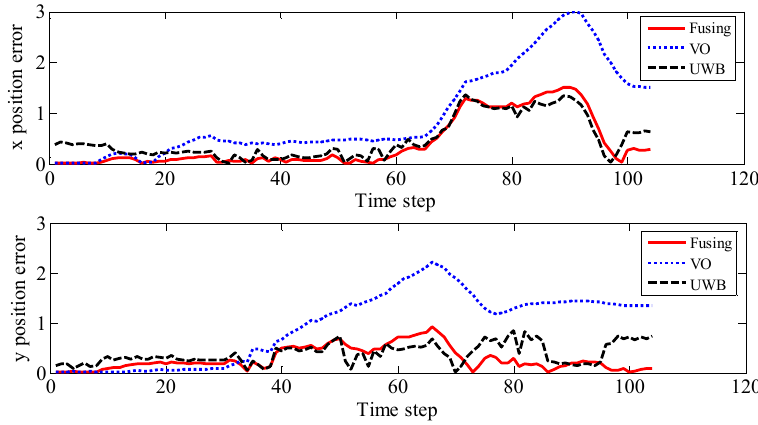
ff erent positioning methods in X and Y Figure 12. Position error of different positioning methods in X and Y directions. Figure 12. Position error of di